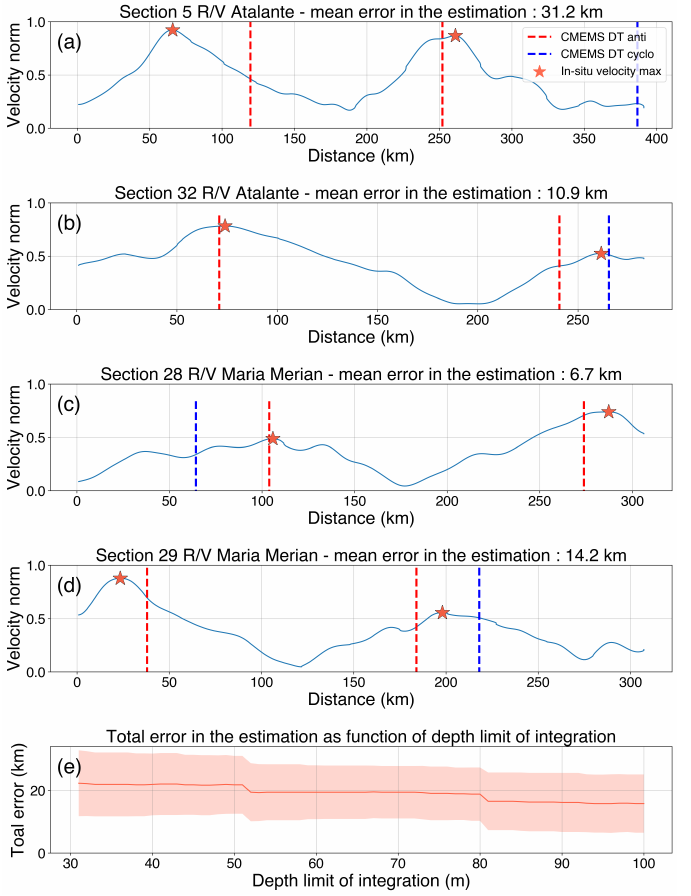
Figure 6. Comparison of the azimuthal velocity maximum position estimated by TOEddies (vertical red/blue lines, for anticyclonic/cyclonic eddies) and by averaging S-ADCP velocities over the first 100 m (red stars). The error in the estimation for each sections of A2 is presented on the first 4 panels. ( a ) Section 5 R/V L’Atalante, ( b ) Section 32 R/V L’Atalante, ( c ) Section 28 R/V Maria S Merian, ( d ) Section 29 R/V Maria S Merian, ( e ) Mean error in the estimation of azimuthal velocity maximum position as a function of depth limit for S-ADCP data